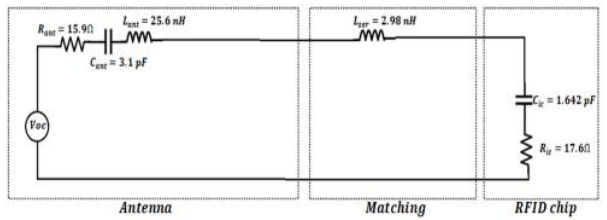
Figure 4: Equivalent circuit model of the proposed RFID tag antenna.